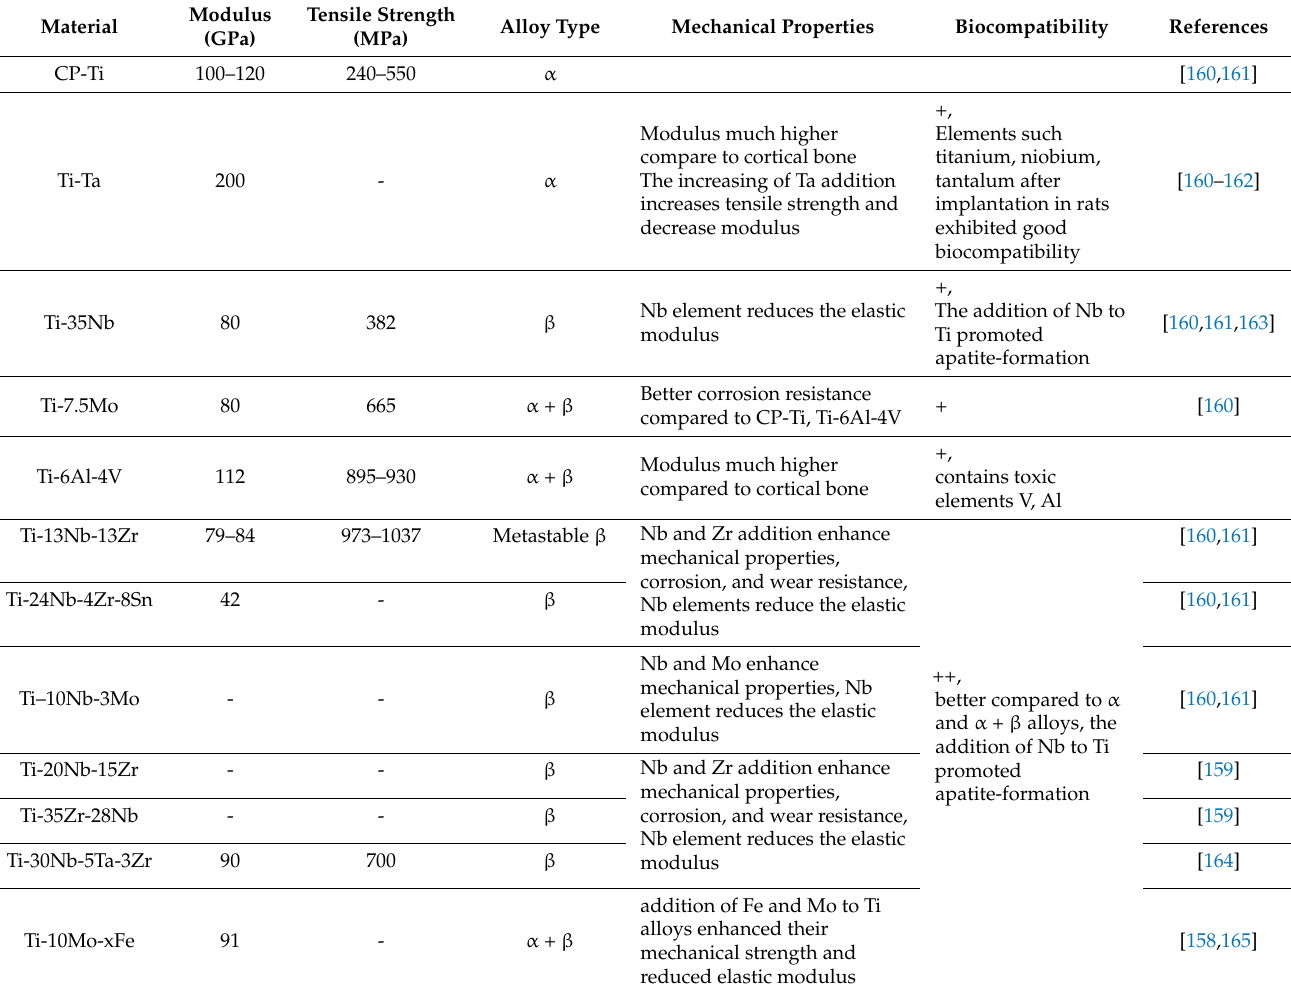
Table 4. The mechanical, structural, and biocompatible properties of titanium alloys used for AM scaffolds. Modulus Tensile Strength Material Alloy (GPa) (MPa)